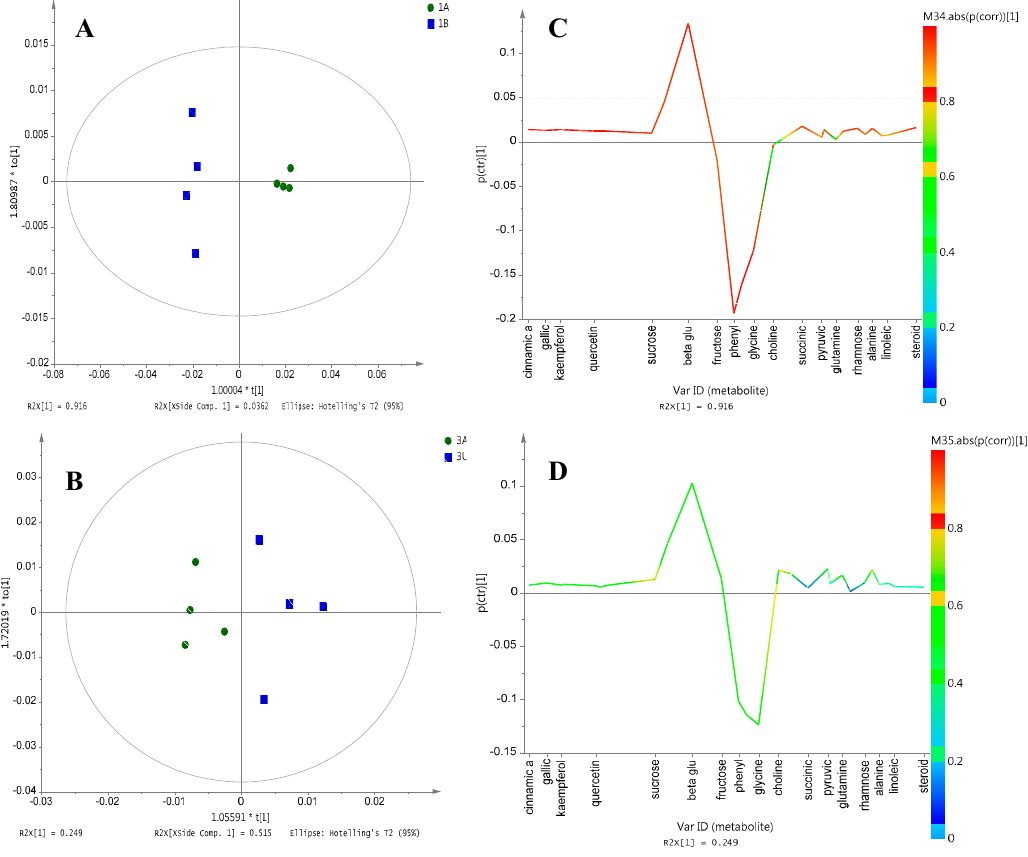
Figure 4. ( A , B ) OPLS-DA score plot; ( C , D ) OPLS-DA S-line plot for Grade 1 Ajwa from different cultivation farms; 1A (Grade 1 from al-Aliah); 1B (Grade 1 from Bir Maashi); 3A (Grade 3 from al-Aliah) and 3U (grade 3 from Uhud).